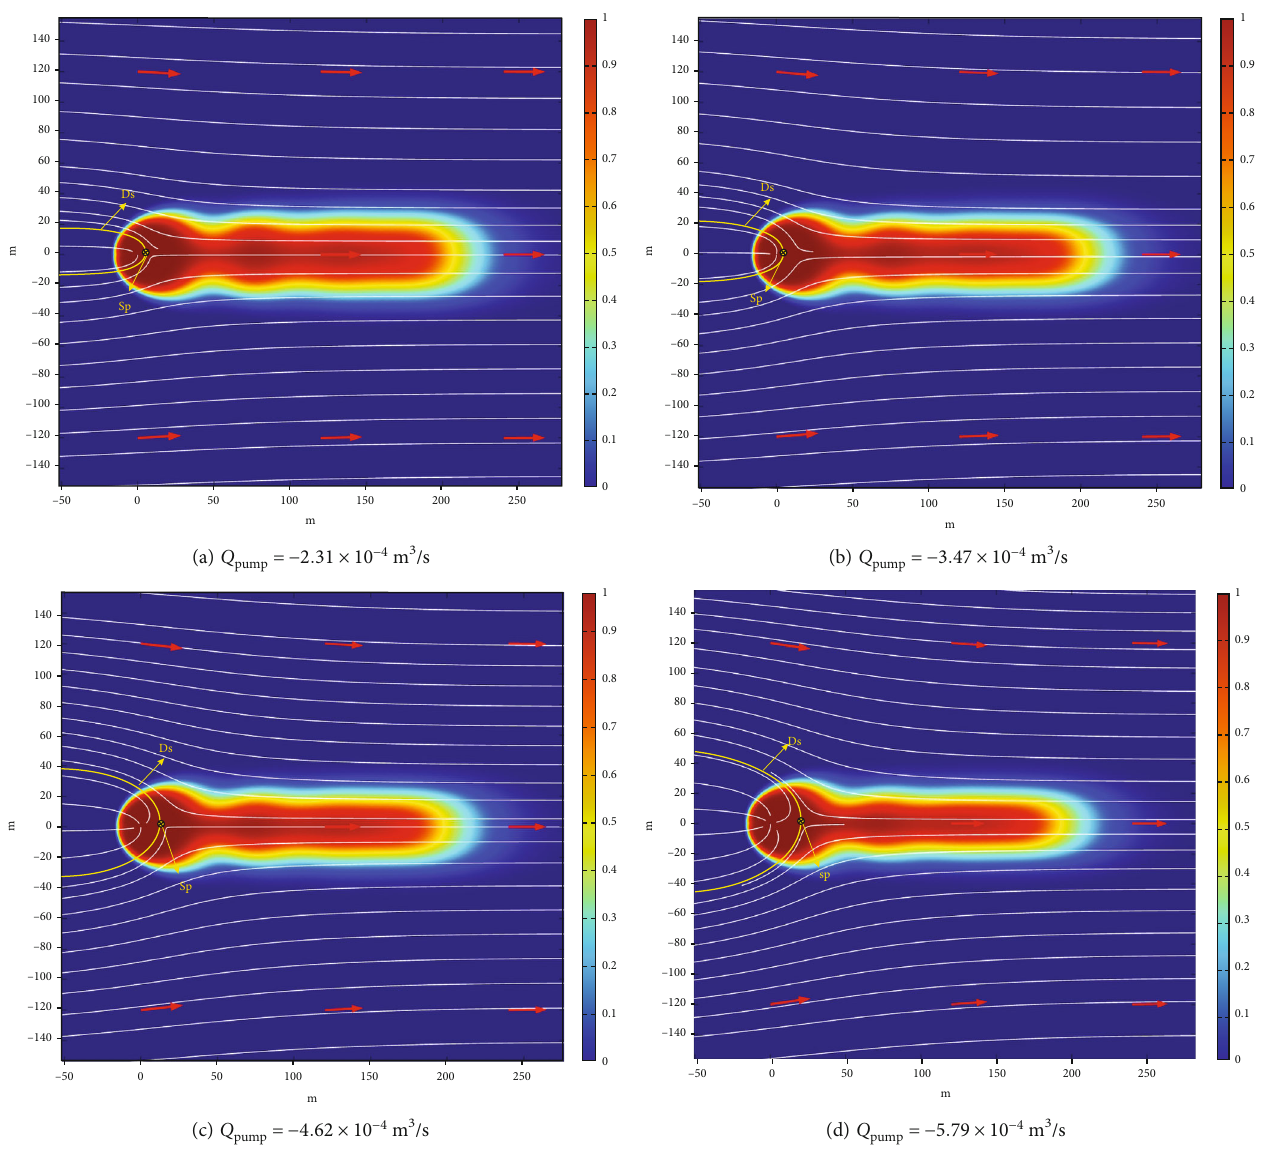
Figure 11: The contaminant concentration distributions in a 2D horizontal plane at t 2 = 270 day with di ff erent pumping rates. (a) Q pump = − 2 : 31 × 10 − 4 m 3 /s; (b) Q = − 3 : 47 × 10 − 4 m 3 /s; (c) Q = − 4 : 62 × 10 − 4 m 3 /s; (d) Q = − 5 : 79 × 10 − 4 m 3 pump pump pump